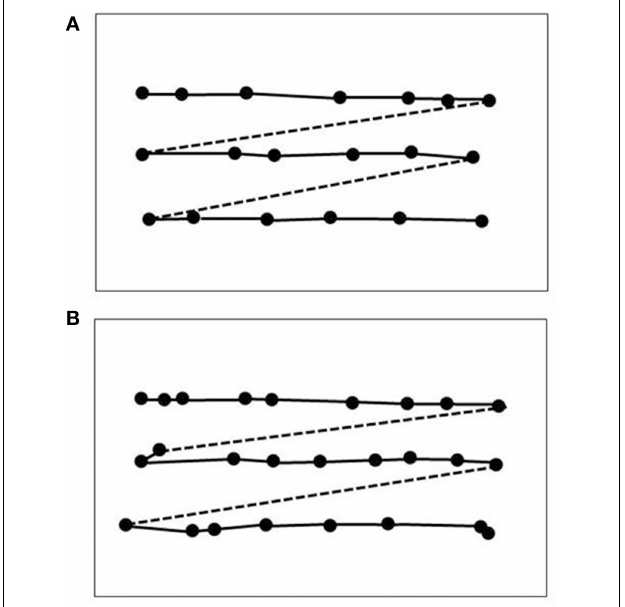
FIGURE 2 | Reading eye movement patterns in an age-matched normal subject (A; same as in Figure 1B) and in LM (B). Dots indicate fixation positions. Reading performance in the normal subject was 156 words per minute (wpm), in LM 72 words per minute. The slowness in LM can be explained by a higher number of fixation repetitions (22.7% in LM vs. 4.3% in the normal subject) and in longer fixation durations (0.31s on average in LM vs. 0.22s in the normal